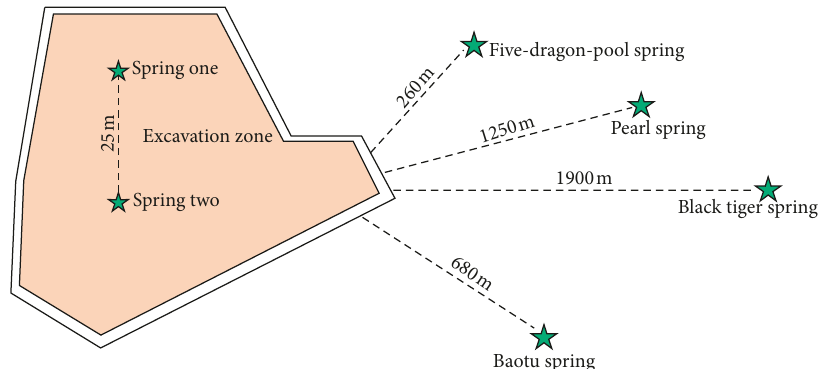
Figure 3: Location of excavation site (not to scale).